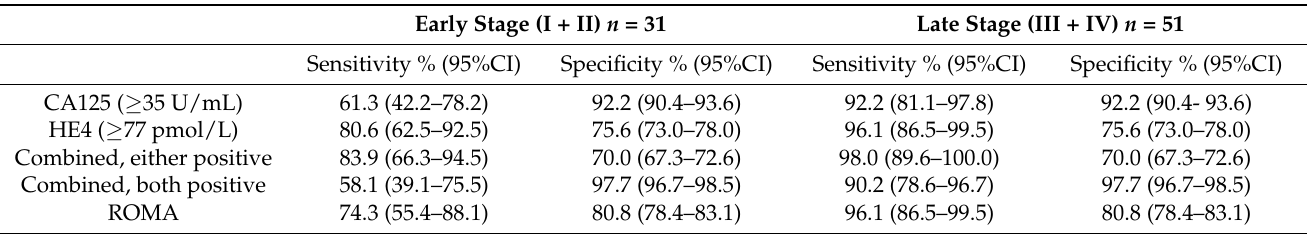
Table 7. Sensitivity and specificity of serum HE4, CA125 (alone and in combination) and ROMA for the detection of early- and late-stage ovarian